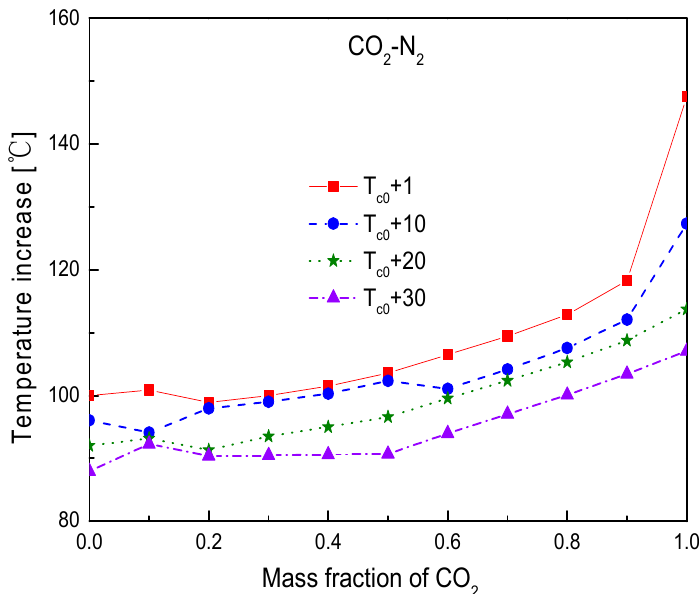
Figure 21. Temperature increase of CO 2 -N 2 in the primary heater at different compressor inlet temperatures.